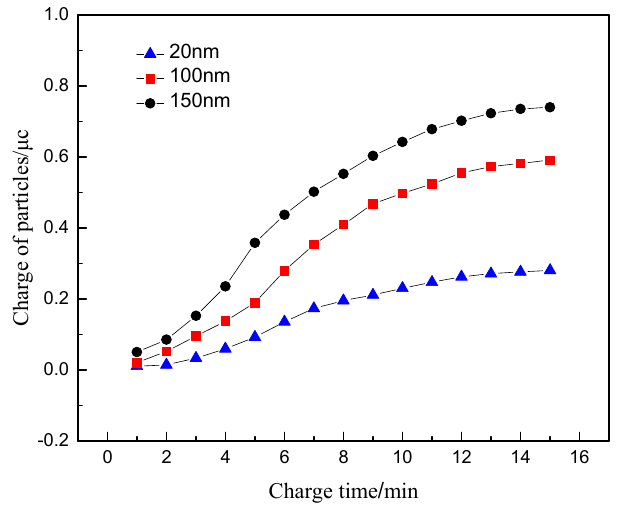
Figure 7. The relationship between the charge amount of particles with different particle sizes and time.